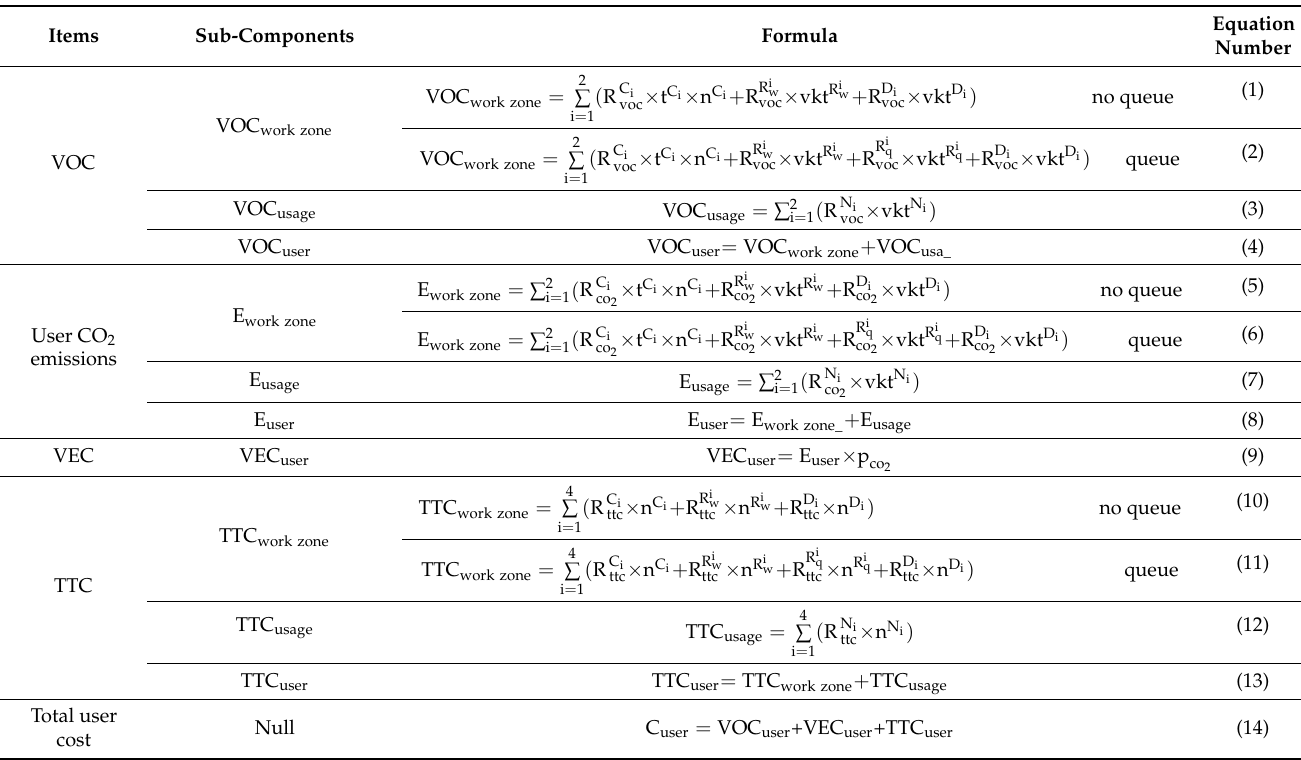
Table 1. The calculation methods of user costs and user CO 2 emissions used in this